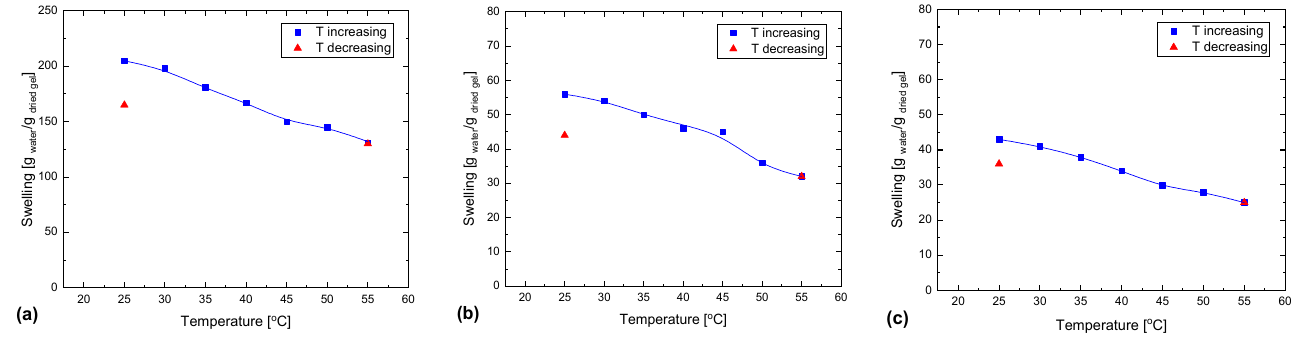
Figure 8. Temperature-depending swelling of 5% HPC hydrogels, containing CMC and the cross-linker; CMC%/PEGDA% composition and dose: ( a ) 5/2.5, 50 kGy; ( b ) 2.5/5, 25 kGy; ( c ) 2.5/5, 50 kGy.